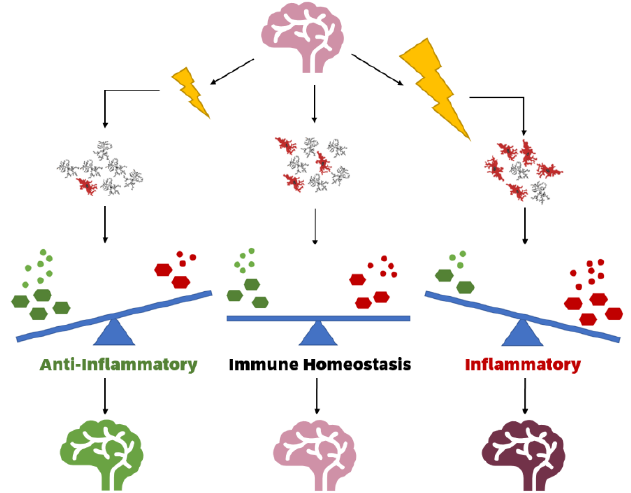
Figure 1. Ionising radiation modulates inflammatory response in a healthy brain by altering micro- glial functional states. Low dose ionising radiation (left) may reduce the number of activated micro- glia, increasing antioxidants and anti-inflammatory cytokines and thus having a neuroprotective effect when compared to a control brain (middle). High dose ionising radiation (right) increases the number of activated microglia, which increases oxidants and pro-inflammatory cytokines, creating a neuroinflammatory state.